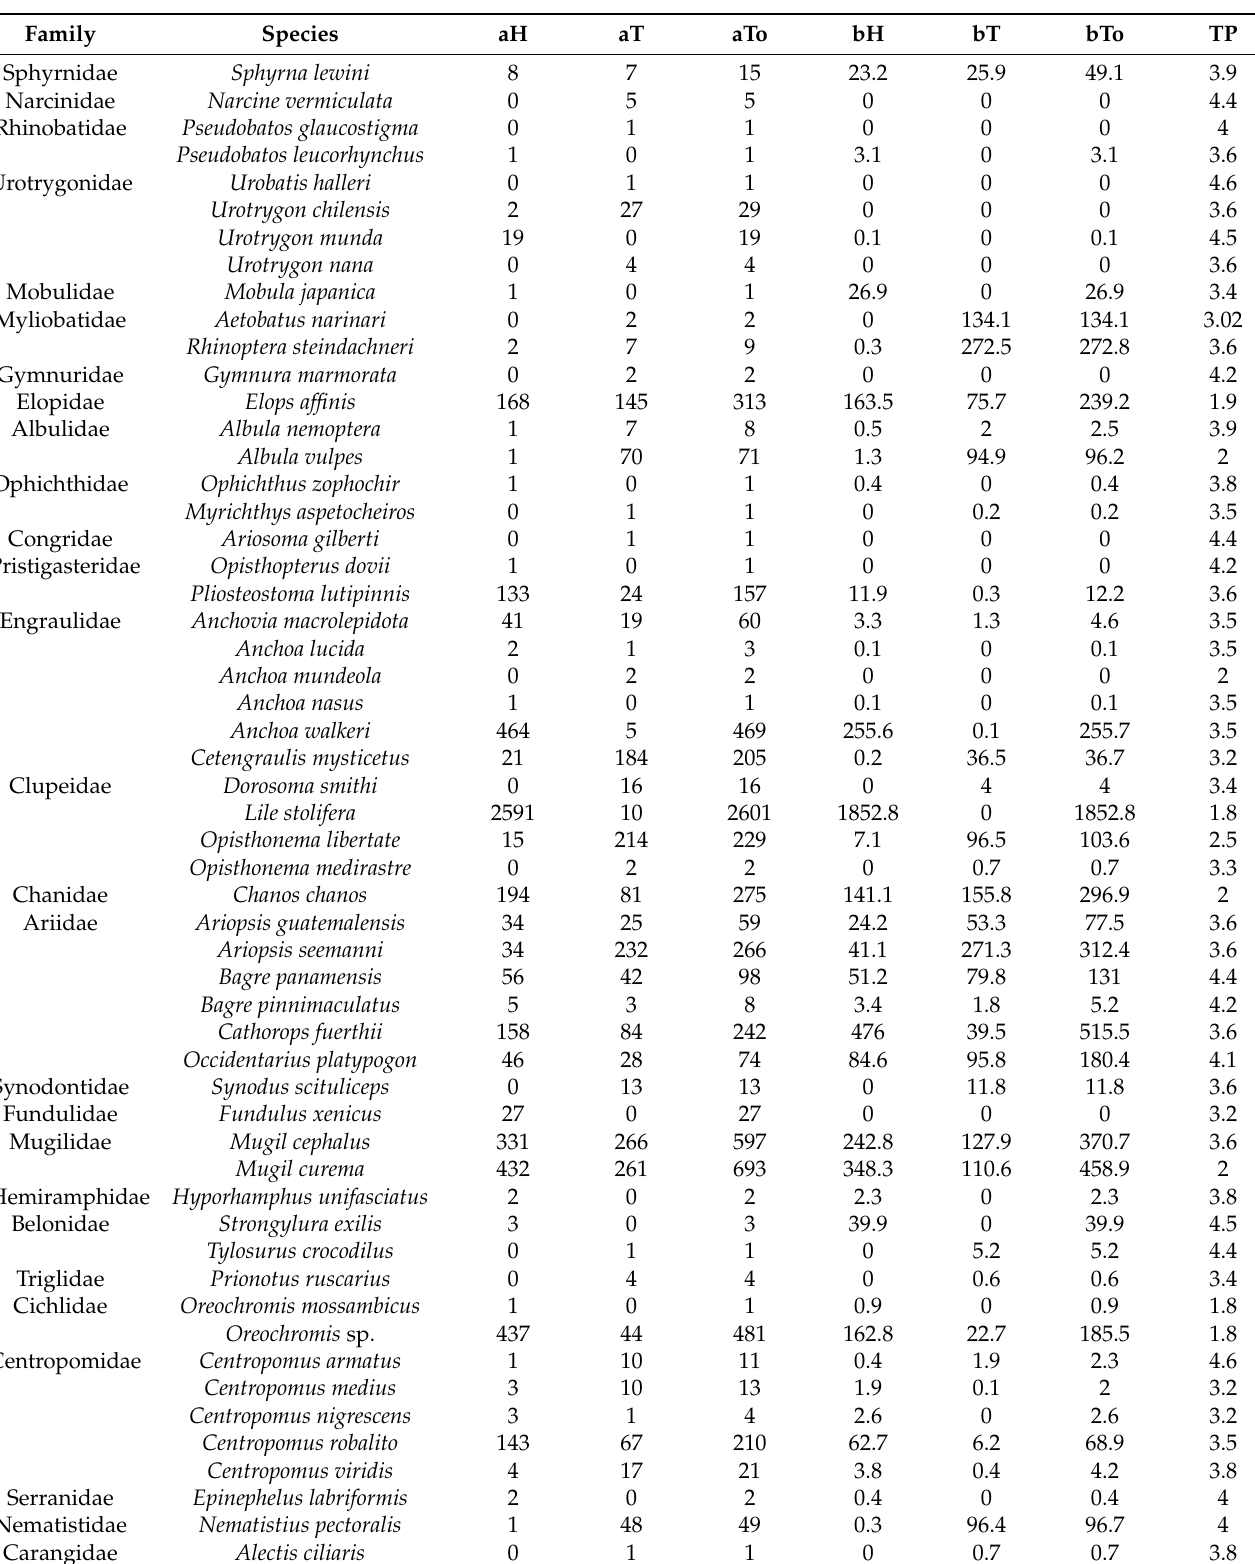
Table 1. Abundance and biomass of the fish species analyzed in this study. a = abundance, b = biomass, H = Huizache-Caimanero, T = Teacapan, To = total of the two systems combined, TP = trophic position